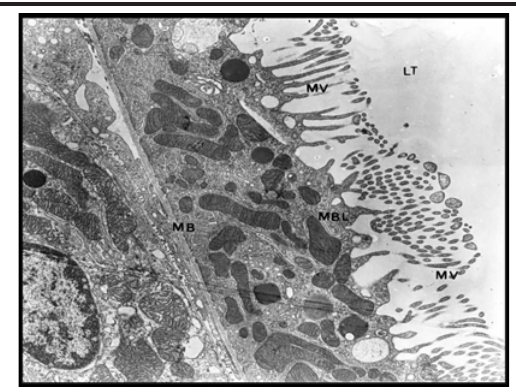
FIGURE 7 - Electronic photomicrography (4.725 X) of proximal tubule from the GI at the time 4 (28 days), demonstrating tubular cells with undifferentiated appearance associated with loss of cellular polarity. Mitochondrion and other intracellular organelles in reduced number. Simplification of basolateral membranes, amongst reduction of cellular height. The microvilosities of the brush border are markedly reduced. [ LT : Tubular lumen, MV : Microvilosities, MB : Basal membrane, MBL : Basolateral